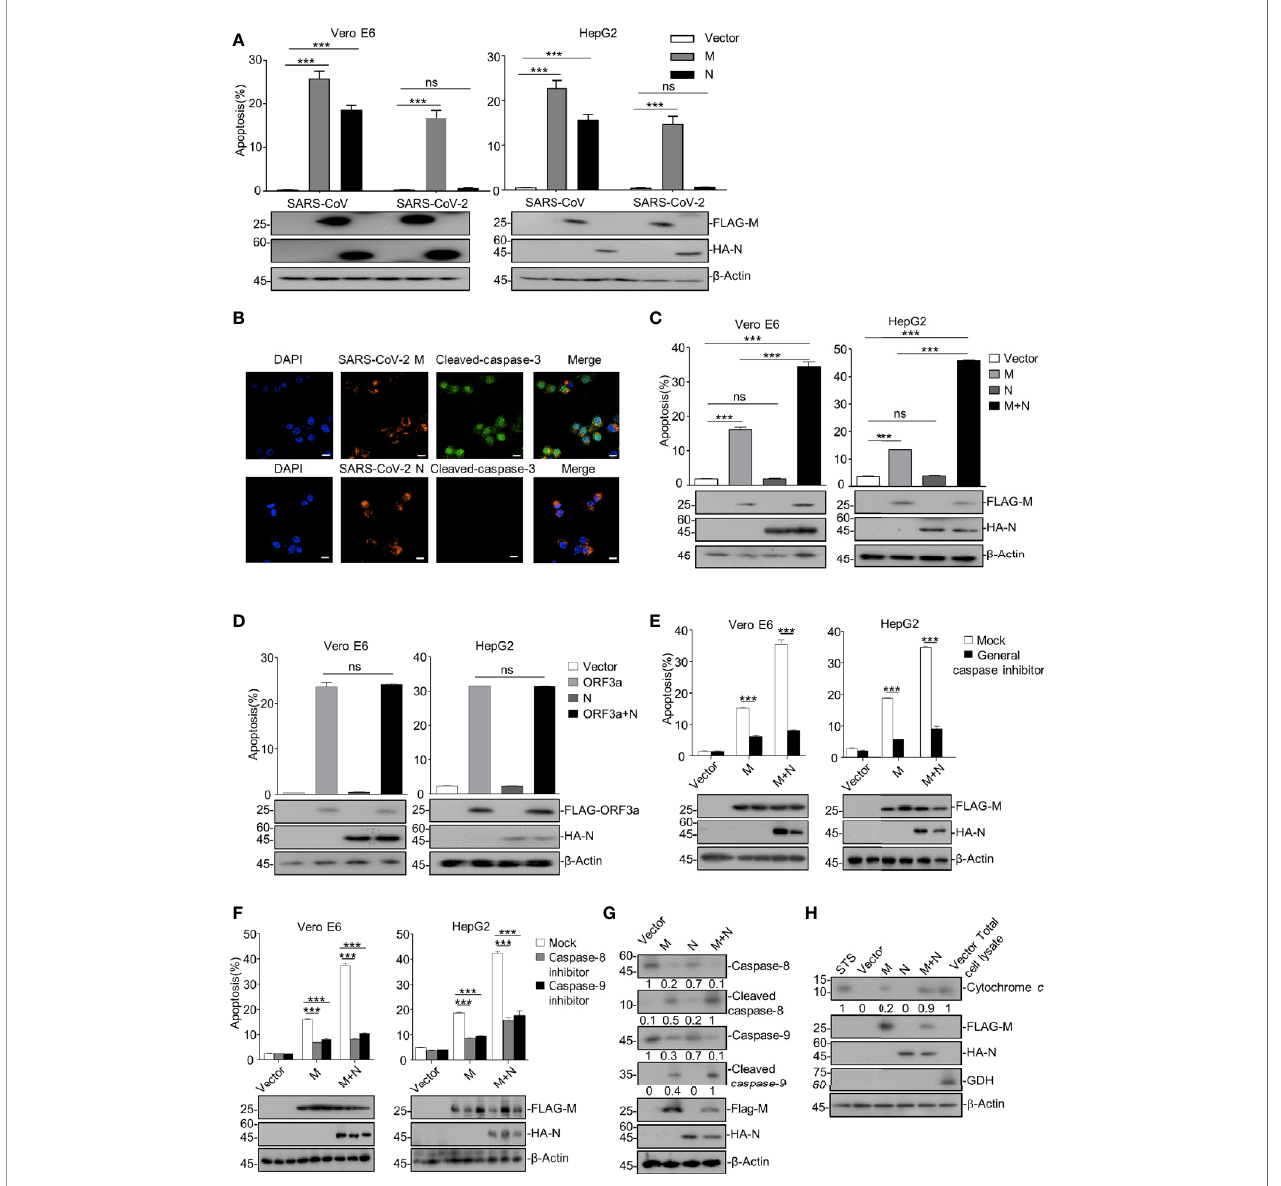
FIGURE 1 | SARS-CoV-2 M induces caspase-dependent apoptosis, and N speci fi cally enhances M-induced apoptosis. (A) Vero E6 and HepG2 cells were transfected with FLAG-SARS-CoV-2 M (M), HA-SARS-CoV-2 N (N), and FLAG-SARS-CoV-2 M plus HA-SARS-CoV-2 N (M+N), also with the counterparts of SARS- CoV. After 24 h, cells were stained with Annexin V-FITC/PI for fl ow cytometry analysis, and the percentage of apoptotic cells was measured. (B) Vero E6 cells were transfected with FLAG-SARS-CoV-2 M or FLAG-SARS-CoV-2 N, respectively. After 24 h, cells were processed for immuno fl uorescence and co-stained with anti- FLAG and anti-cleaved-caspase-3 antibodies indicated. Scale bar, 20 m m. (C) Vero E6 and HepG2 cells were transfected with FLAG-SARS-CoV-2 M (M), HA-SARS- CoV-2 N (N), and FLAG-SARS-CoV-2 M plus HA-SARS-CoV-2 N (M+N). After 24 h, cells were collected for Western blotting (with anti-FLAG, anti-HA, or anti- b -